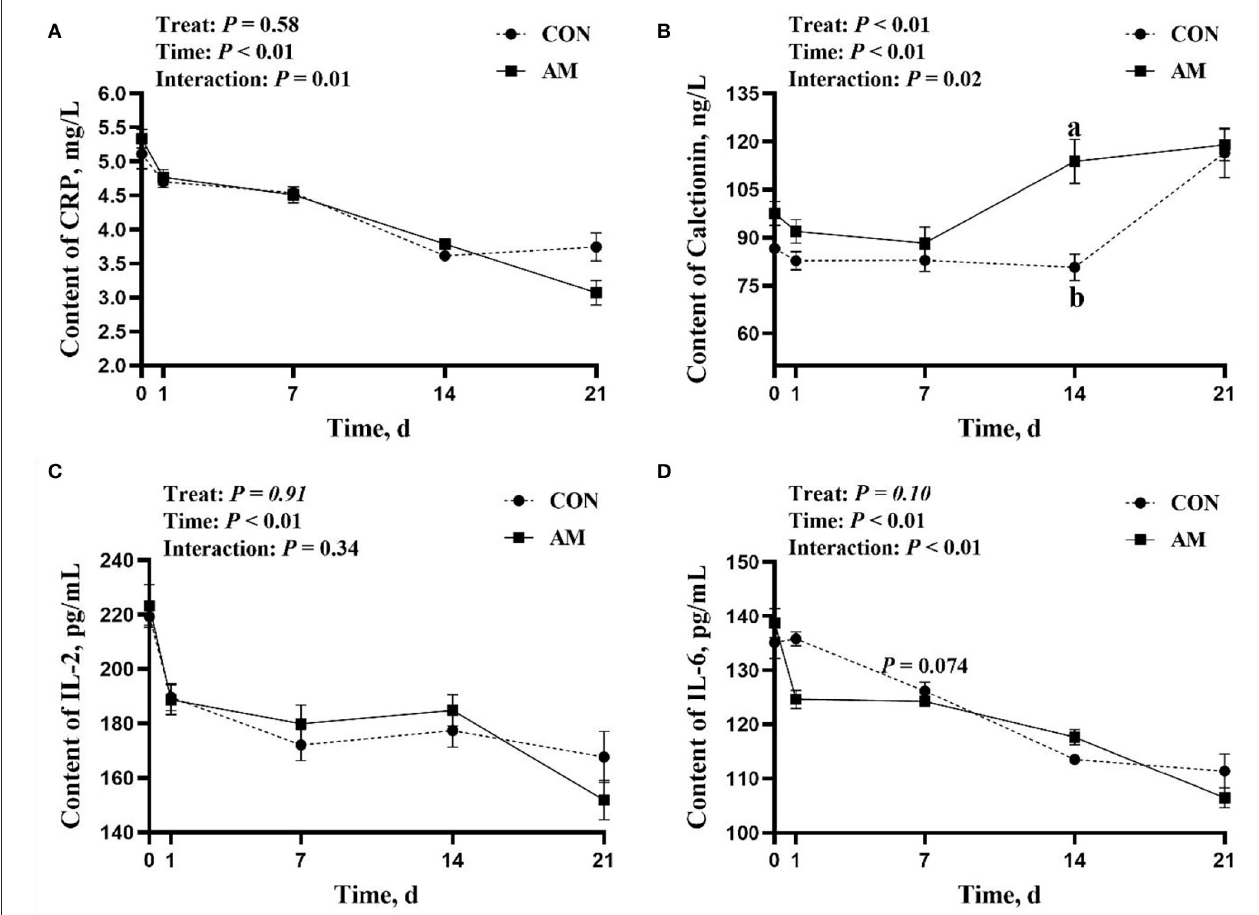
FIGURE 2 | Inflammatory factor of CON and AM in Holstein dairy cows at 21 days postpartum. (A) C-reactive protein, (B) Calcitonin, (C) IL-2, (D) IL-6. Data shown are means ± SEM. Different lowercase letters indicate significant